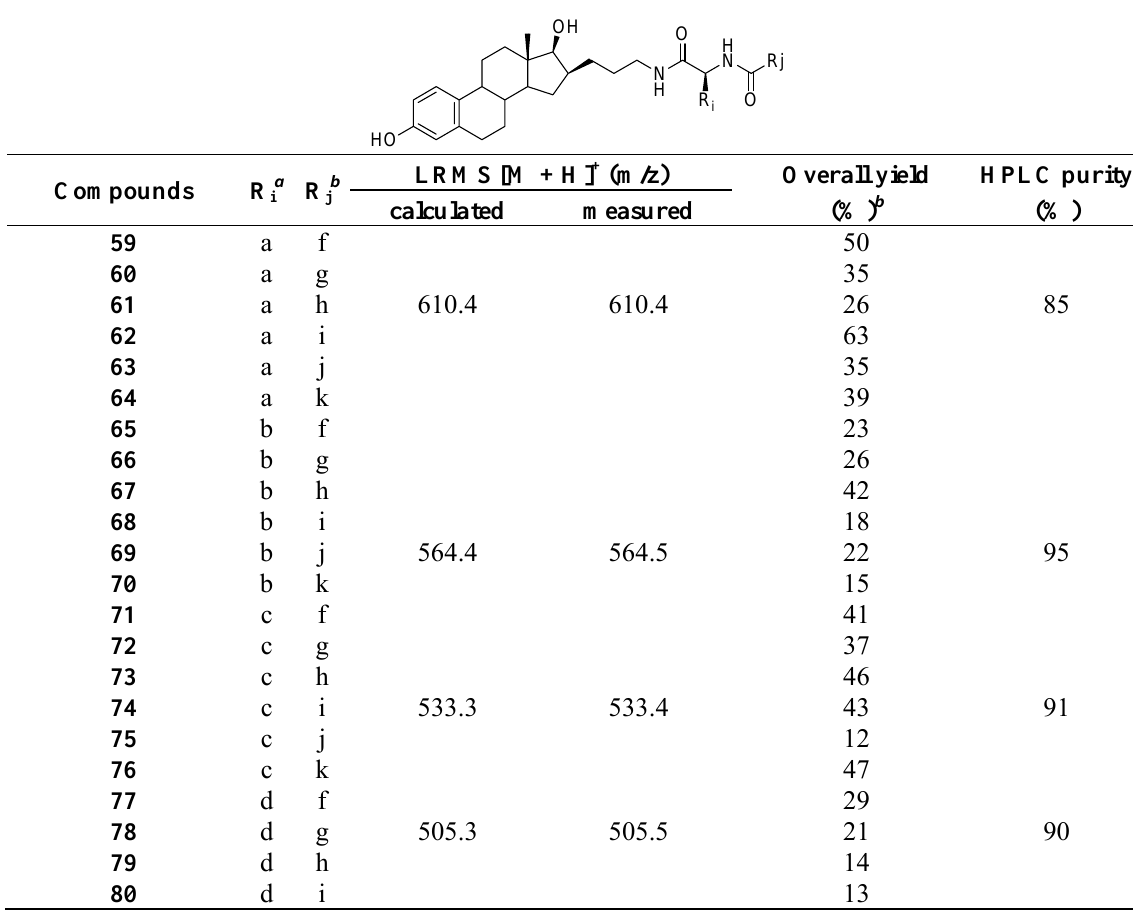
derivatives 59–88 2